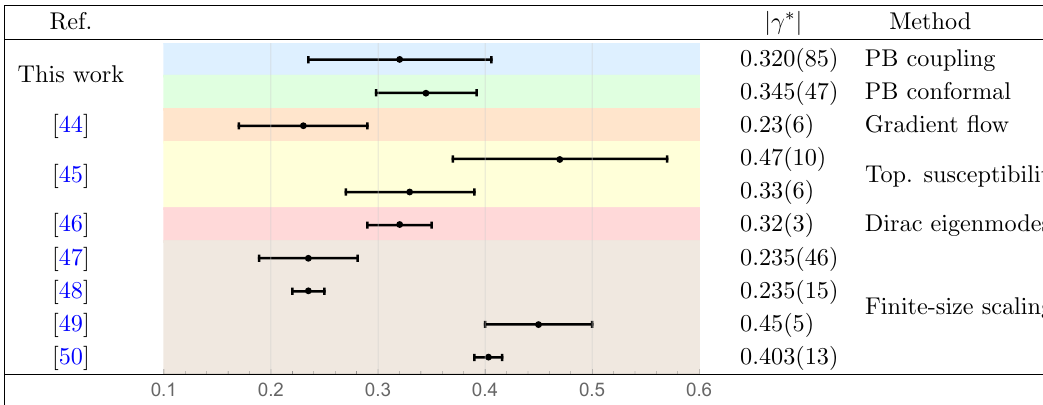
Table 2 . Comparison between the results of our Pad(cid:19)e-Borel (PB) resummation for j (cid:13) (cid:3) j in QCD with n f = 12 | both using the coupling expansion and the Banks-Zaks conformal expansion, and averaging over all available Pad(cid:19)e approximants in each case | and lattice results.